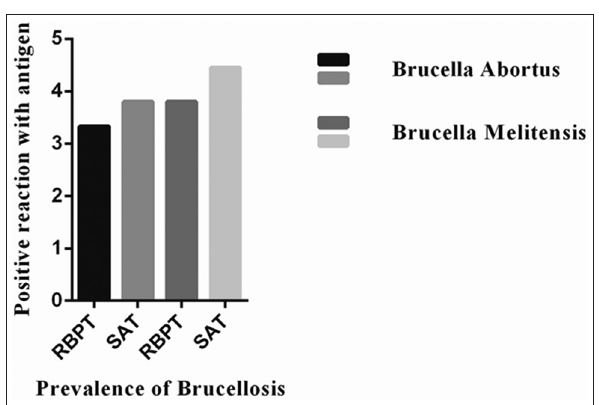
Figure-3: Animals reacted with Brucella melitensis antigen showed a positive reactor of 3.8% through rose Bengal plate test (RBPT) and 4.45% by serum agglutination test (SAT) as well as Brucella abortus indicated 3.33% positive reactor by RBPT and 3.8% SAT. The data expressed as percentage